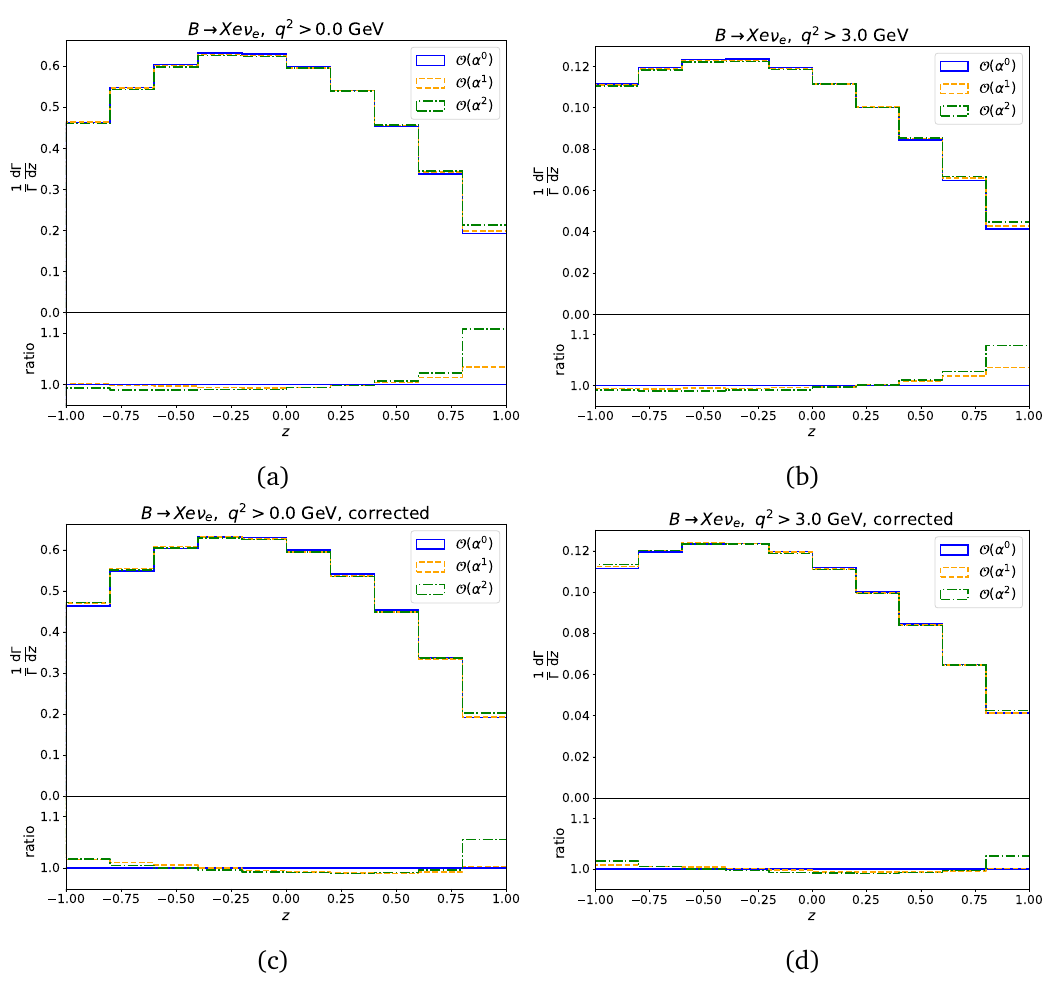
Figure 5: The differential decay rate for B → X e ν decays for different treatments e of the final-state radiation. The figures in the left column do not include a cut on q 2 , while the figures in the right column include a lower cut on q 2 of 3 GeV 2 . In the two figures in the upper row no correction for hard-collinear radiation was applied, whereas for the two figures in the lower row the photon with the highest energy within a 5 ◦ cone around the electron was combined with the electron. The labels ( α 0 ) , ( α 1 ) and ( α 2 ) denote no final-state radiation, soft final-state radiation O O O only and a full YFS treatment,